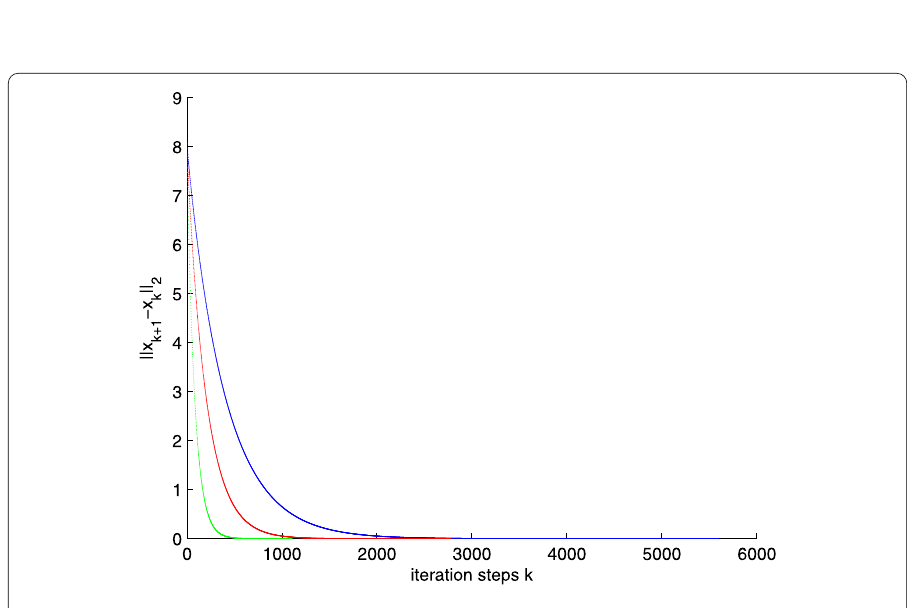
Figure 1 The convergent iteration steps with different α for Example 1. Each curve in this graph represents the convergent iteration steps for different α , with γ = 1 The yellow curve represents α = 5 × 10 –2 ; the red curve represents α = 2 × 10 –2 ; and the blue curve represents α = 1 × 10 –2 .